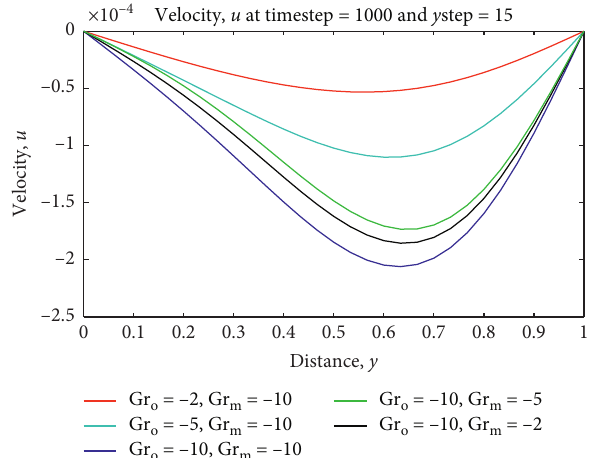
Figure 6: Effects of negative values of mass and thermal Grashof number on primary velocity